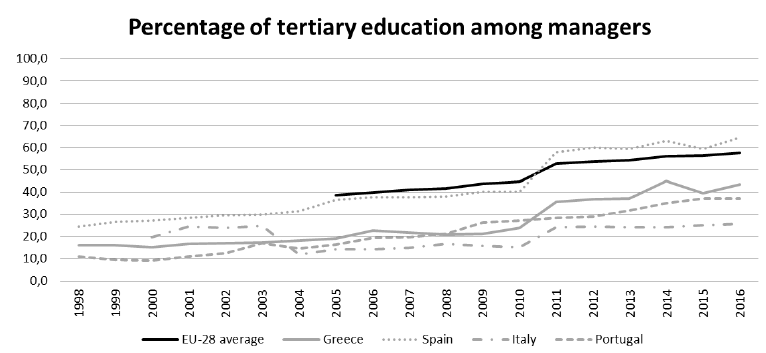
Figure 5: Percentage of managers with tertiary education among managers 1998-2016